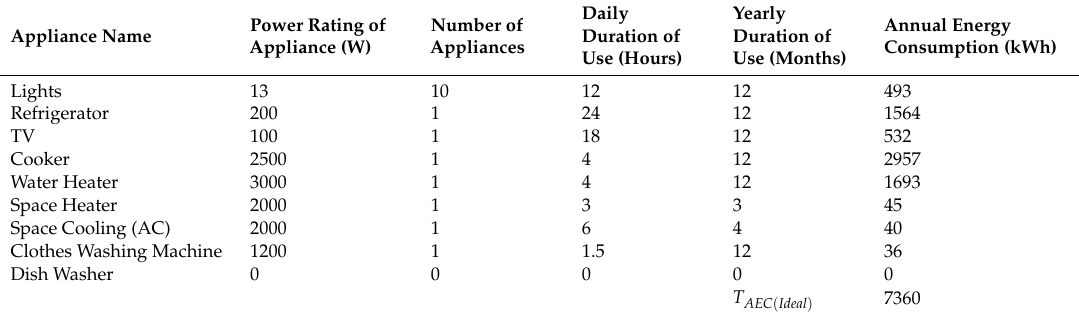
Table 2. Ideal total annual appliance energy consumption.